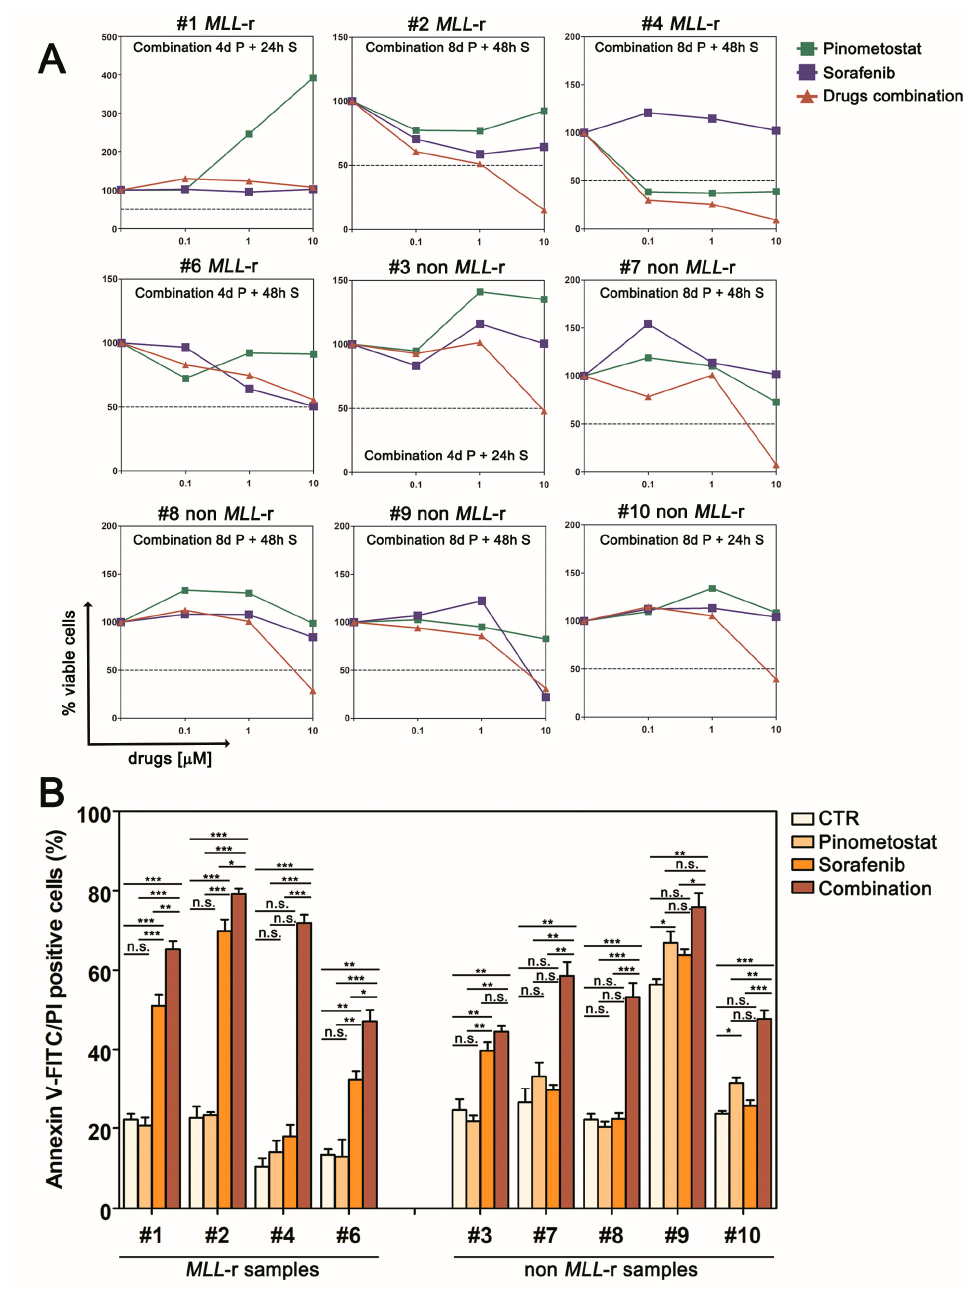
Figure 5. Pinometostat sensitizes primary cells from pediatric AML patients to Sorafenib treatment. ( A ) Growth curves of primary AML cells pre-treated with Pinometostat before Sorafenib addition (Pinometostat/Sorafenib ratio 1:1). The pre-treatment model consists of 4 or 8 days of treatment with Pinometostat followed by 24 or 48 h treatment with Sorafenib. Combination times are indicated in each panel. ( B ) Flow cytometry analysis of apoptosis measured by Annexin V-FITC/PI staining in primary AML cells treated with 10 µM of Pinometostat (8 days), Sorafenib (48 h), or combined drugs (8 days + 48 h). Ctr: control cells (DMSO 0.01%). Results of three independent replicates are presented as means ± SD.